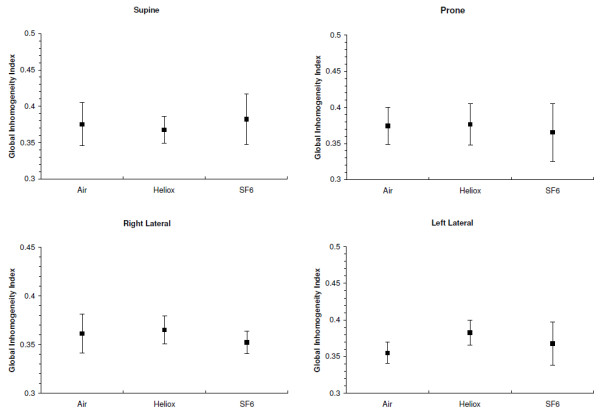
Global Inhomogeneity indices (mean and 95% confidence interval) for the three gas mixtures in each of four body positions.